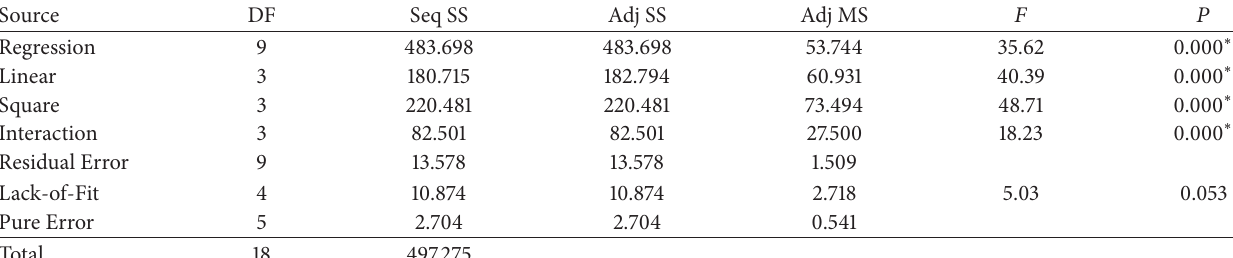
Table 7: ANOVA for recovery (%) without outlier.